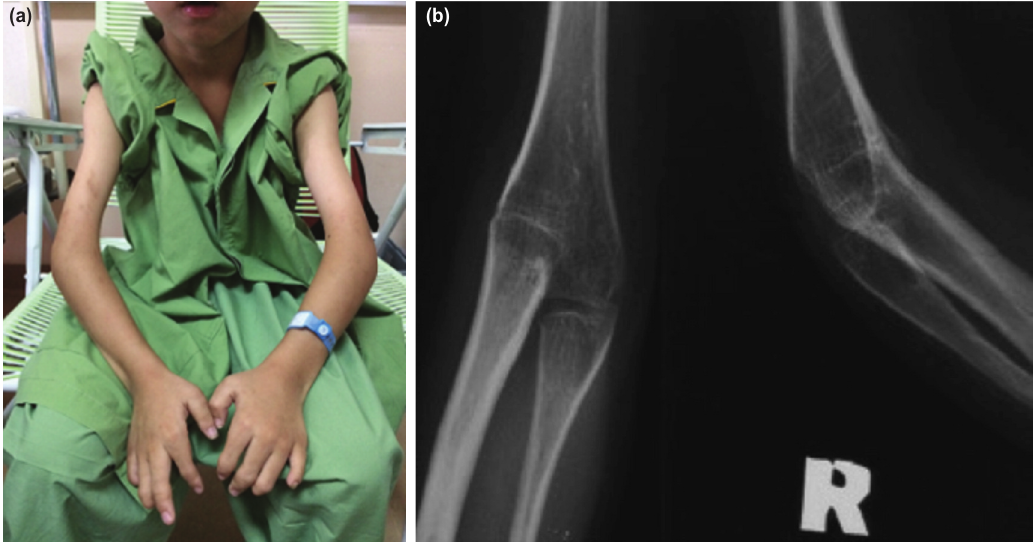
(a) Pre-operative photograph of the patient’s bilateral elbows in fixed flexion of 30 degrees. (b) The pre-operative right elbow Fig. 1: radiograph demonstrating humeroradial synostosis with hypoplastic humeroulnar joint.